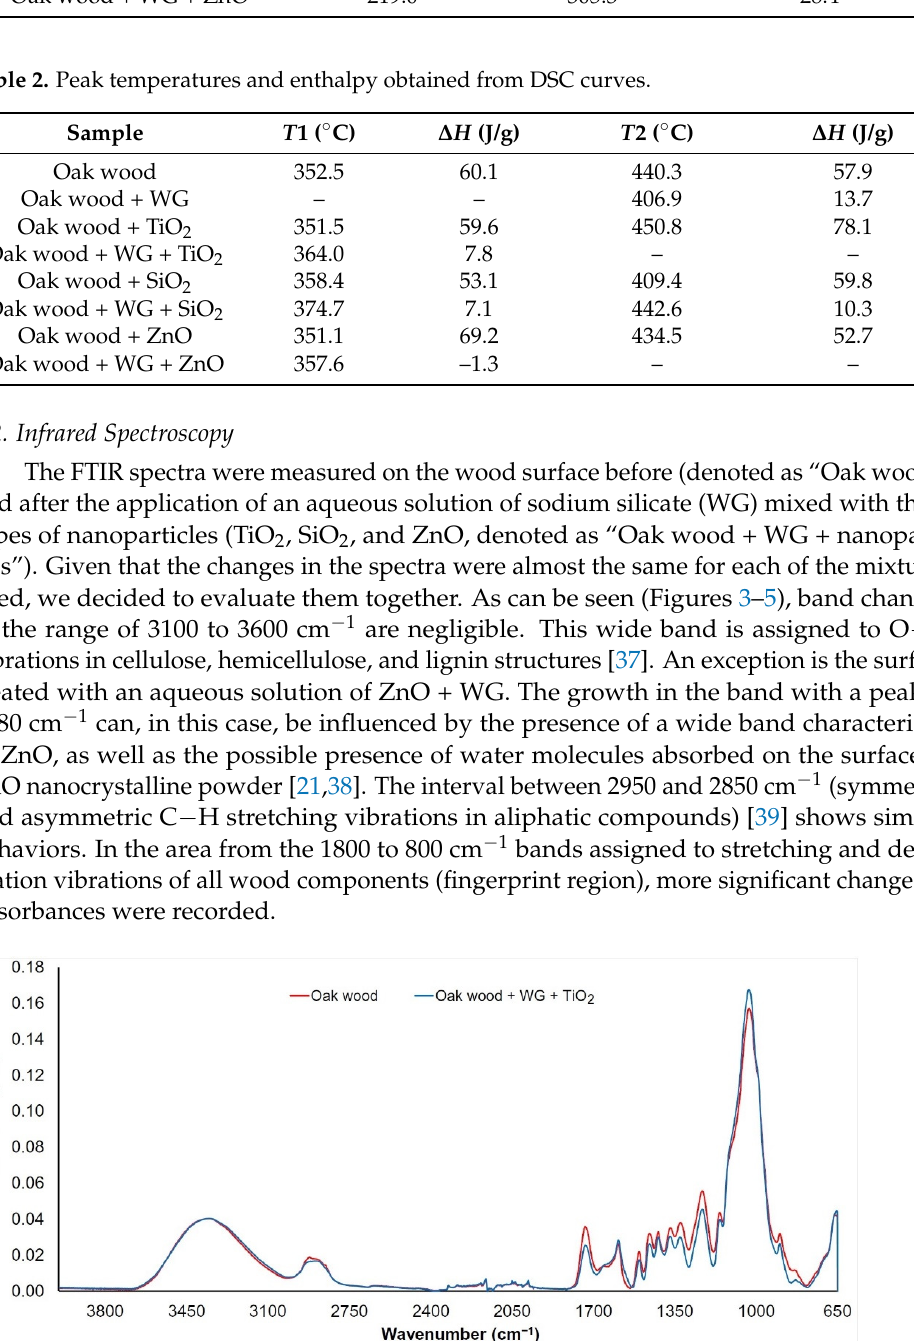
Figure 3. FTIR spectrum of oak wood coated with water glass and TiO 2 nanoparticles. A decrease in band absorbance on 1735 cm − 1 (C=O stretching in unconjugated car- bonyl groups) of more than 35% (Figures 3–5) was observed on the treated samples, indi- cating changes in several functional groups in lignin and hemicelluloses (carbonyls, alde- hydes, ketones, and carboxylic acids) [40,41]. This decrease may be due to changes in the polysaccharides due to the action of an alkaline Na 2 SiO 3 solution. Alkaline treatment of wood promotes the deacetylation of hemicelluloses and has an effect on the degradation of xylans [42]. A separation of xylans and glucomannans is also found in wood [21]. The band around 1600 cm − 1 (C=C stretching conjugated with an aromatic ring in lignin) is prac- tically unchanged. An exception is a sample treated with a solution containing ZnO na- noparticles, where an increase in absorbance of about 25% was observed. This may be due to overlap with the relatively wide band present in the ZnO spectrum (Zn − O stretching vibrations in crystalic structures) [43,44]. The band absorbance near 1500 cm − 1 (C=C stretching conjugated with aromatic ring in lignin) decreased by around 20%. This mainly indicates a decrease in the number of methoxyl groups, confirming the decrease in lignin content [45,46]. Figure 4. FTIR spectrum of oak wood coated with water glass and SiO 2 nanoparticles. The bands also decreased at 1460 cm − 1 (asymmetric CH 3 bending in methoxyl groups in lignin), 1370 cm − 1 (symmetric and asymmetric CH 3 bending), 1320 cm − 1 (C − O vibration in syringyl derivatives), and 1235 cm − 1 (C − O stretching vibration in xylan and syringyl ring), which are associated with lignin and hemicelluloses [47–50]. Their decrease sup- ports the assumption that lignin degradation is caused by the presence of an alkaline en- vironment (the pH of the water glass solution used in the experiment was more than 10).